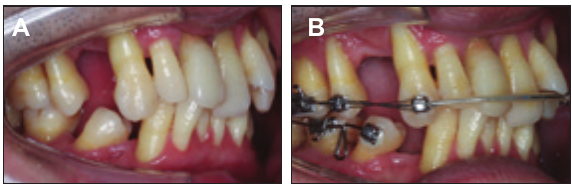
Figure 4. Mesial movement and uprighting of the lower right second premolar. A. Pretreatment; B. The second month, the segmental arch of 0.016 × 0.022 inch stainless steel arch wire with a closing loop to distally move and upright the second premolar.